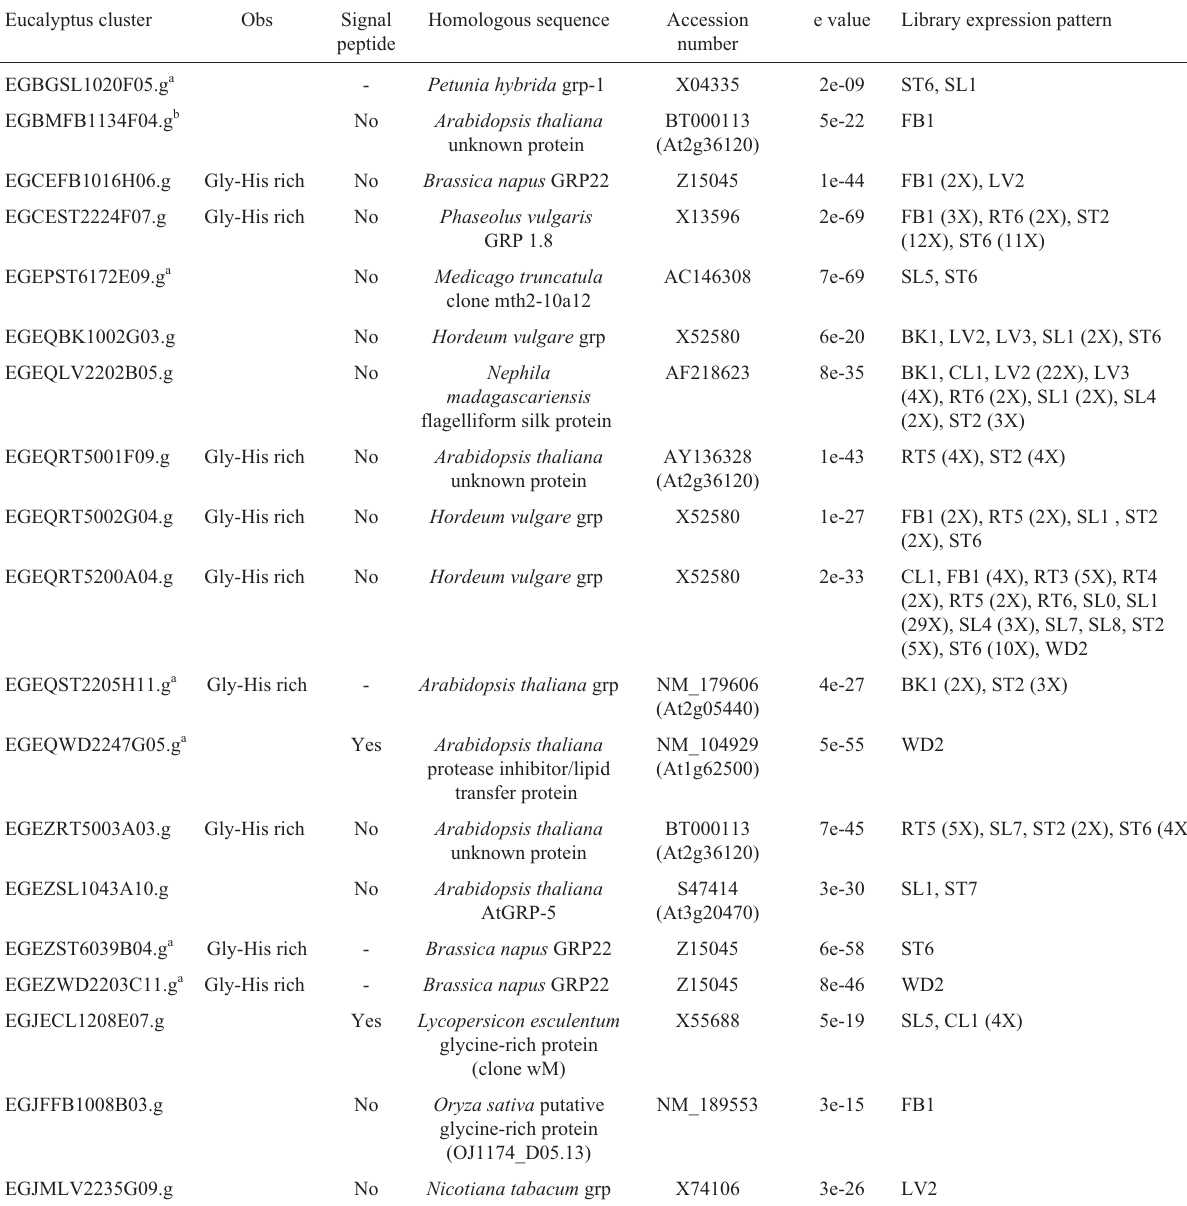
Table 2 - Eucalyptus ESTs encoding GRPs with GGGX repeats. Eucalyptus